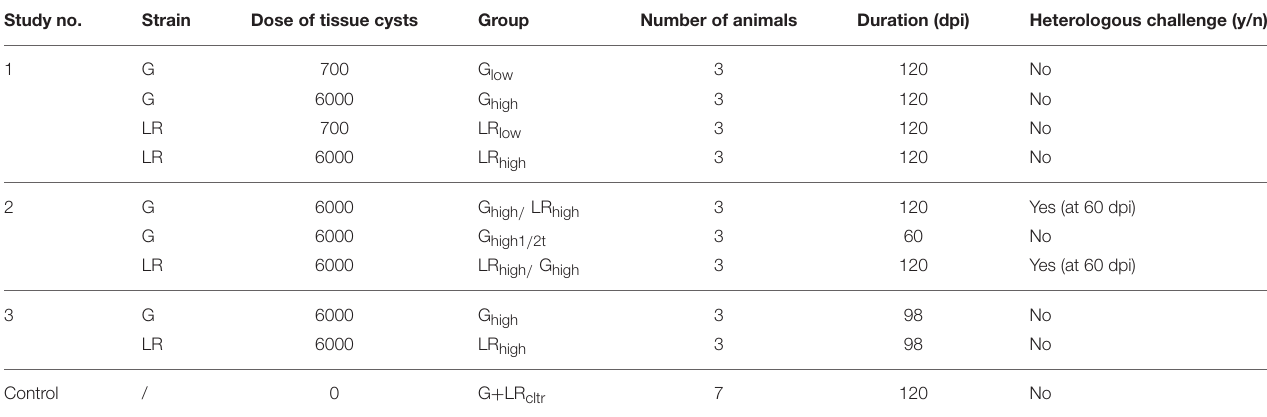
TABLE 1 | Experimental design: G, IPB-G strain; LR, IPB-LR strain. Study